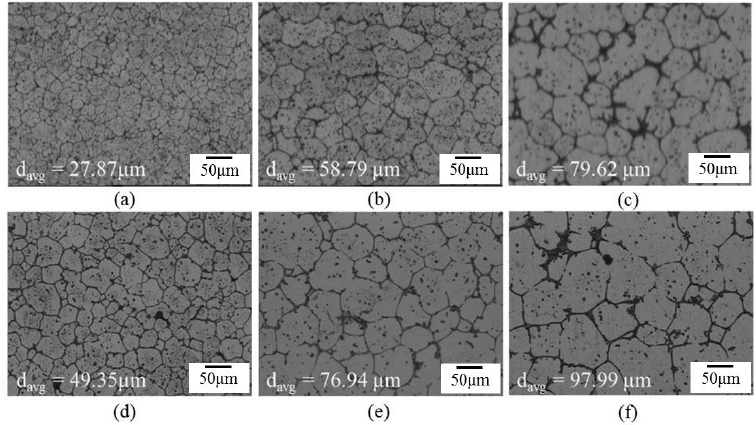
Figure 8. Microstructures of extruded alloys with two thicknesses after salt bath at 620 ˝ C: ( a ) SB3/620-1; ( b ) SB3/620-10; ( c ) SB3/620-30; ( d ) SB9/620-1; ( e ) SB9/620-10; and ( f )